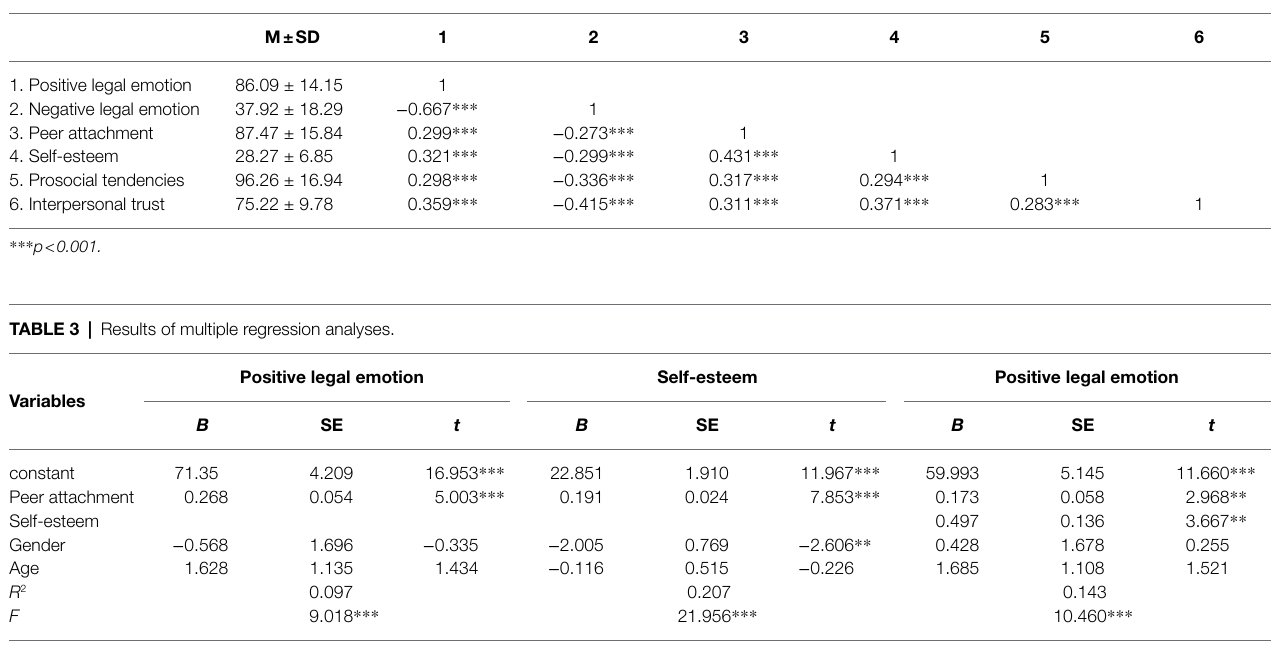
TABLE 2 | Descriptive statistics and correlation matrix of main research variables ( N = 967).